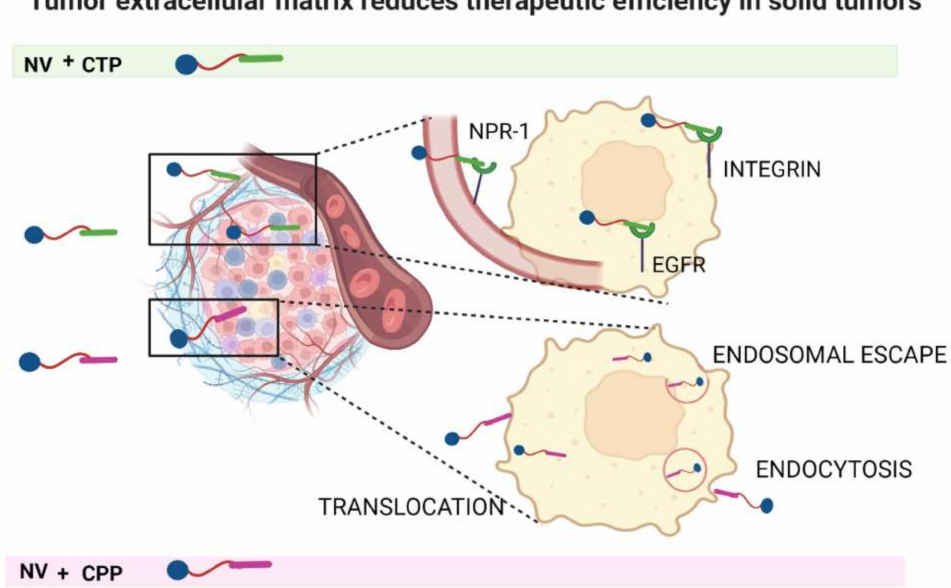
Figure 2. The representation of proposed mechanisms of action of CTP- and CPP-decorated NVs involved in selective drug delivery in cancer cells. CTP exploit overexpressed receptors to selectively target cancer cells; CPP enhance internalization through different mechanisms such as endocytosis, translocation or endocytosis followed by endosomal escape. This figure was created with BioRender. com (accessed on 2 February